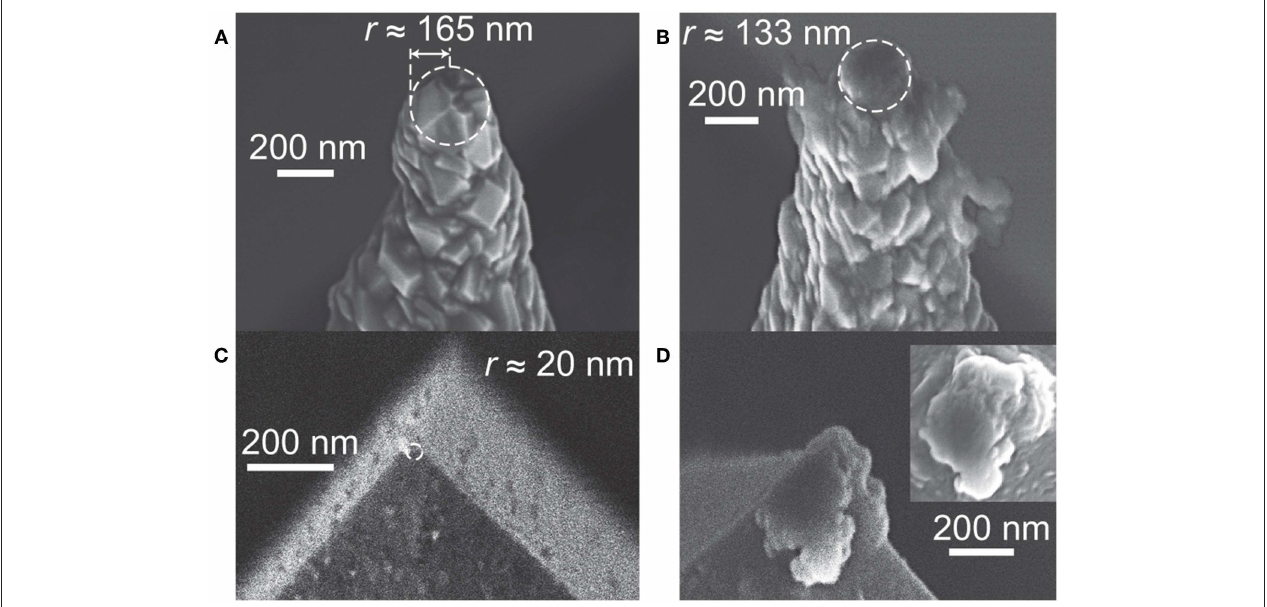
FIGURE 2 | SEM images of unused and used diamond-tipped probes, taken following the processes in Figure 1 . (A,B) New and used diamond-coated probes, respectively. The new probe has a radius of curvature, r , around 165nm, highlighted by the dashed circle. Debris has accumulated on the tip of the used probe, though the apex is not obscured. It also appears blunted, with less well-defined grains, although it is sharper (i.e., has a lower r ) than the new probe. (C,D) New and used full-diamond probes, respectively. Initially, the full-diamond probe is sharper than the diamond-coated probe; r is difficult to determine from the image, though we have estimated it to be 20nm. Following use, the apex appears obscured by debris, so it is difficult to discern whether it is blunt. Inset—top-down view of the probe in (D) ; the apex is entirely obscured by debris. Note that for both probe types the unused probes are representative and are not the same probes used for etching